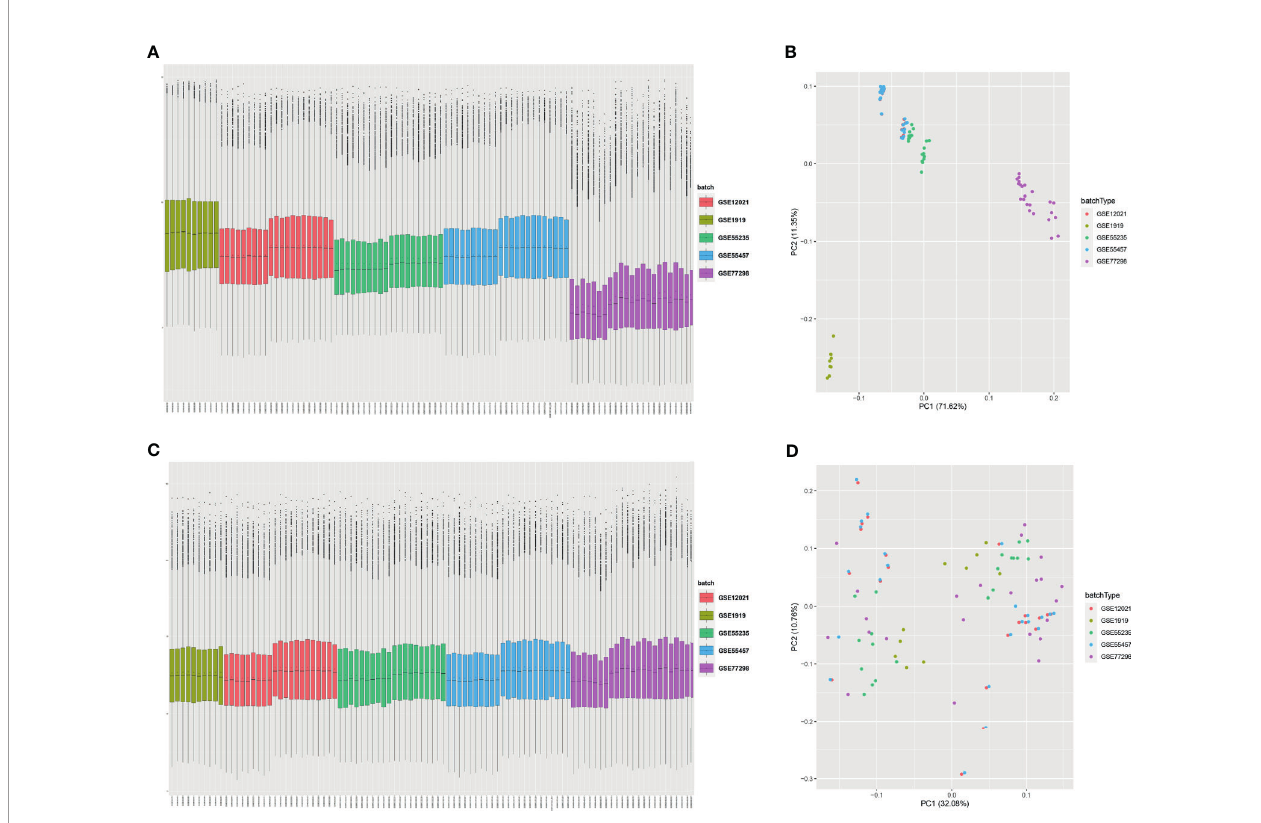
FIGURE 1 | Data preprocessing. Box plot and principal component analyses were performed to remove batch correction of GSE1919, GSE12021, GSE55235, GSE55457, and GSE77298. (A, B) before batch correction and (C, D) after batch